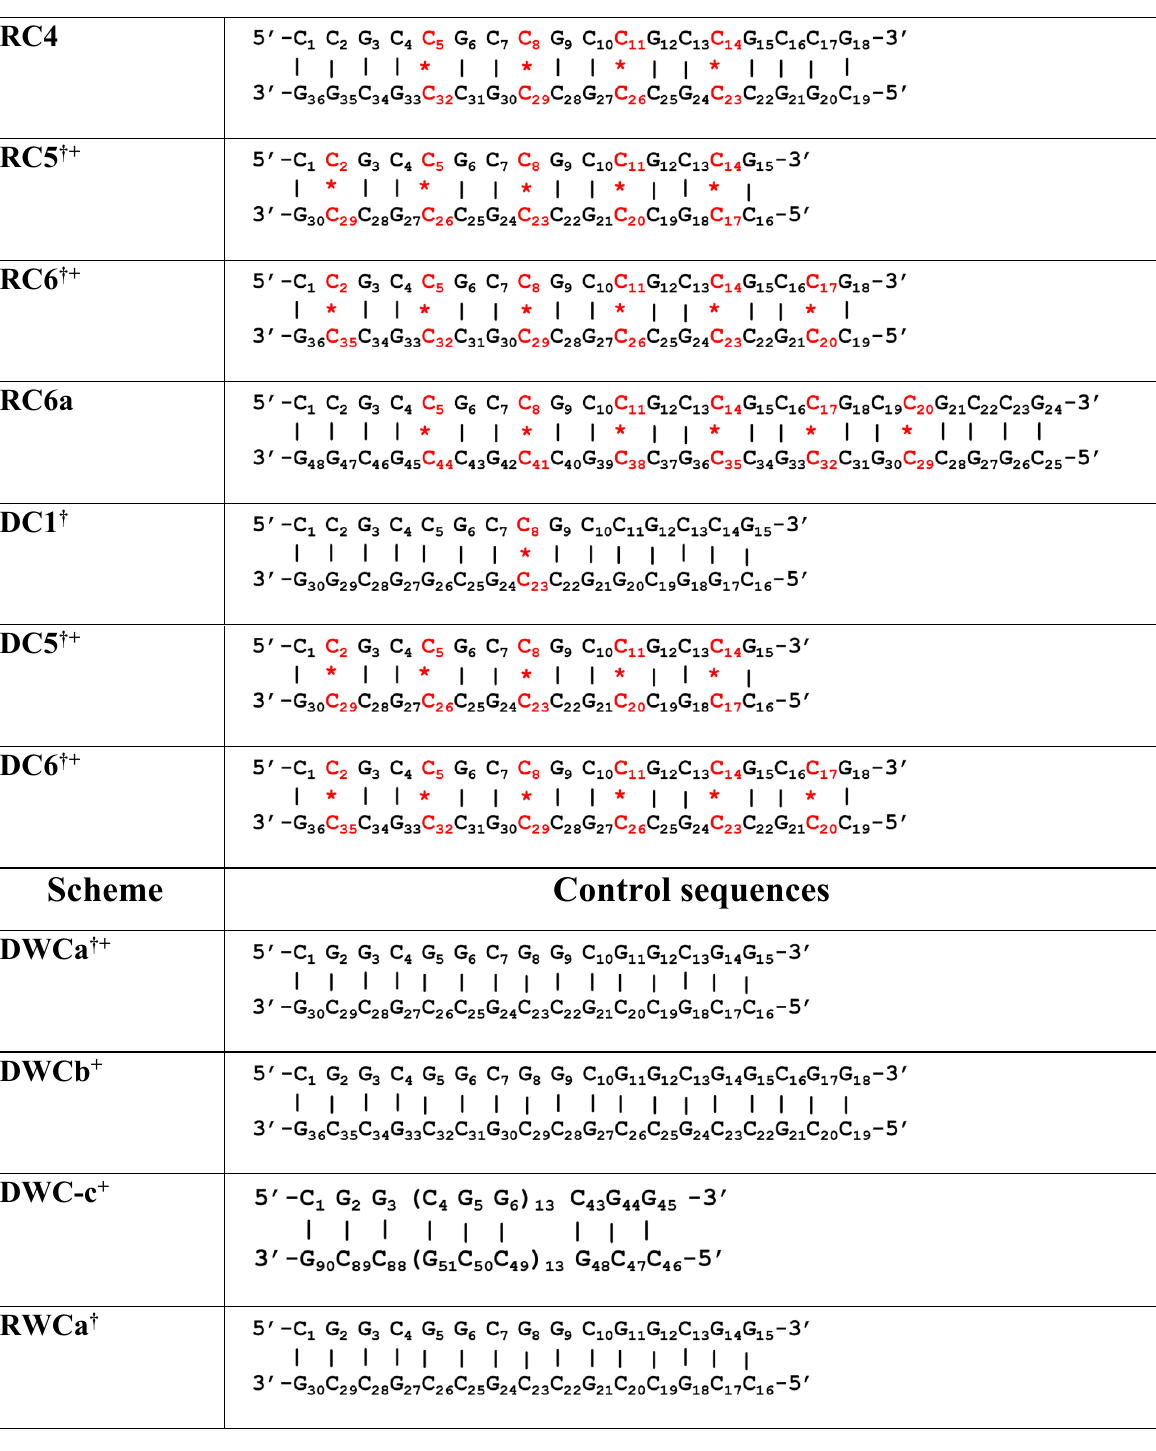
Table 1. CGG and CCG repeats containing DNA and RNA duplexes considered for MD, EMSA and CD investigations. The scheme name starting with R and D represents RNA and DNA, respectively and